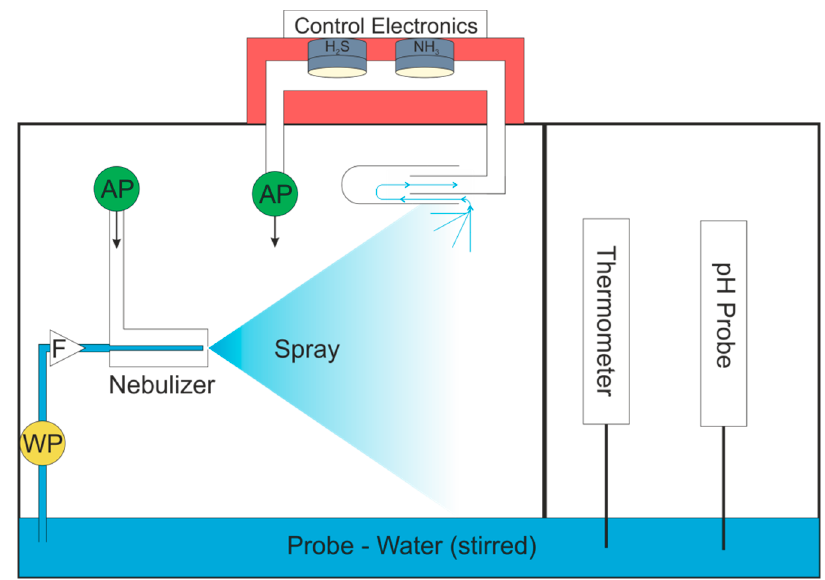
Figure 7. Automated system for real world water quality testing. WP = water pump; AP = air pump; F = filter.